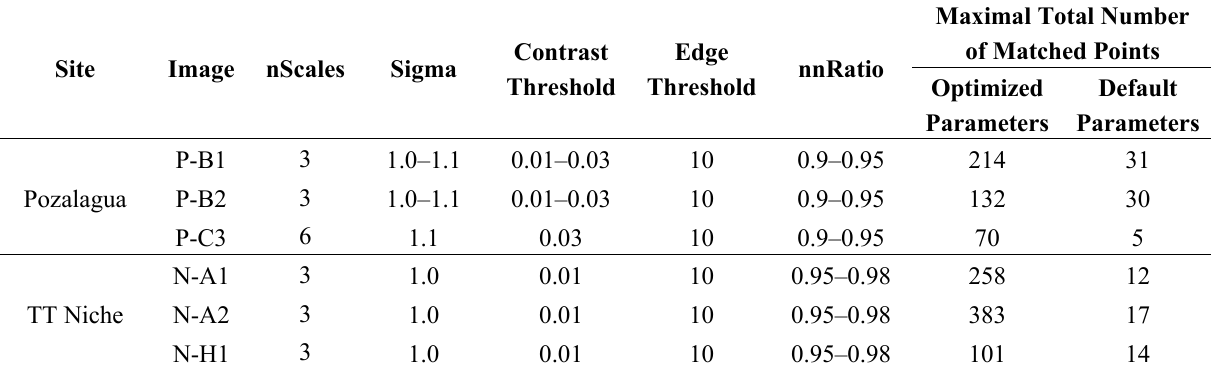
Table 4. Optimized SIFT parameters with corresponding number of points matched in nine bands of the hyperspectral images.